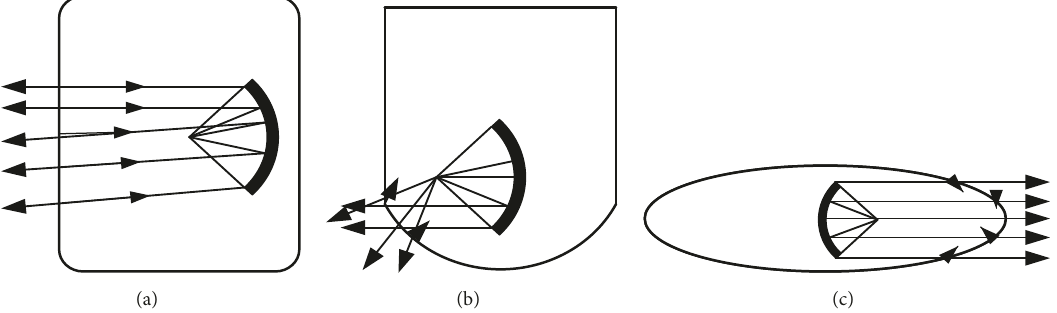
Figure 1: Different radome shapes: (a) cylindrical; (b) cylindrical-hemispherical; (c) spheroidal or ogival [16].